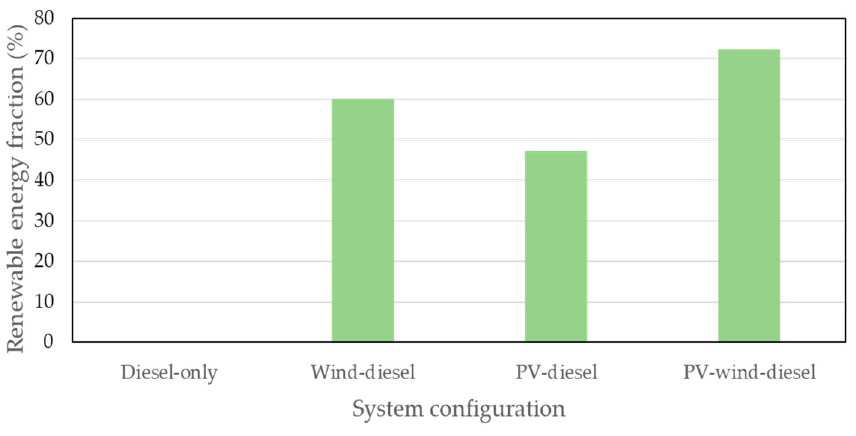
Figure 10. Renewable energy fraction for each optimal system configuration.